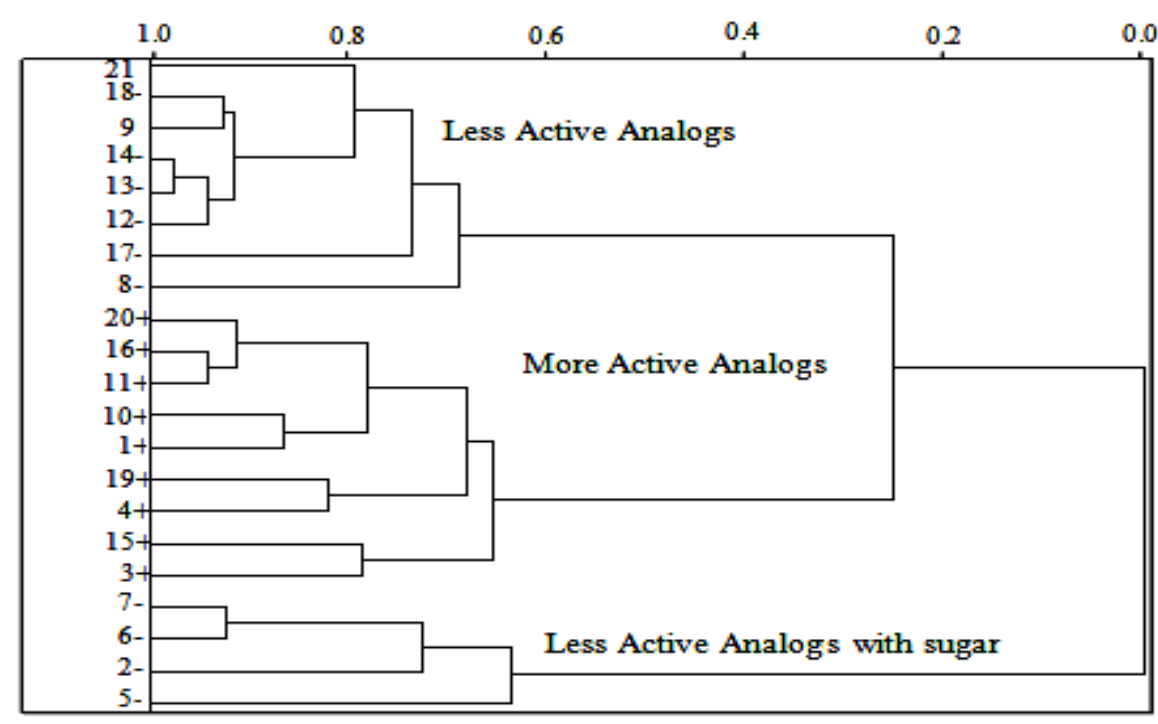
Figure 6. HCA dendrogram for artemisinin and derivatives with biological activity against W-2 strains of P. falciparum. Positive values indicate more potent analogs, and negative values indicate less active